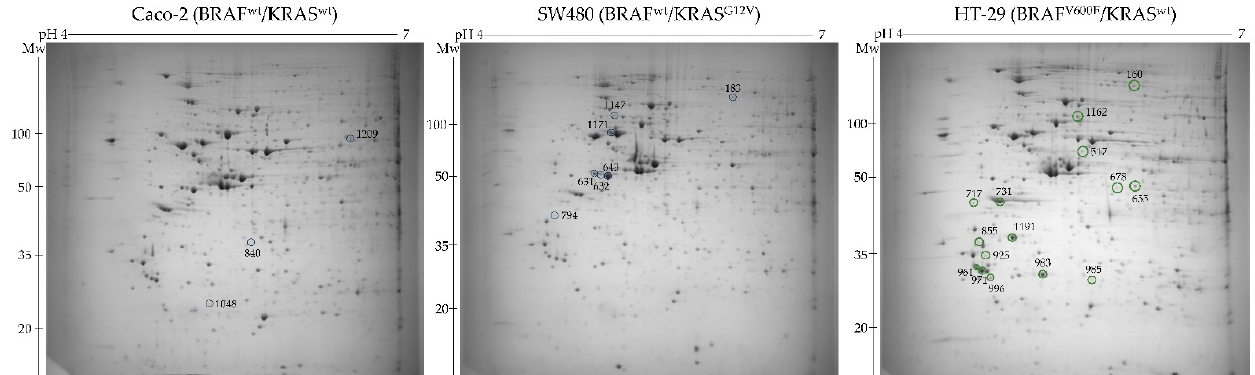
Figure 1. Representative 2-DE gel images of total cell proteome obtained in the pH range 4–7 from the three colon cancer cell lines differing in BRAF mutational status. Marked with a green circle are up-regulated protein spots detected in BRAFV600E mutant cells, while blue circles designate down-regulated protein spots.